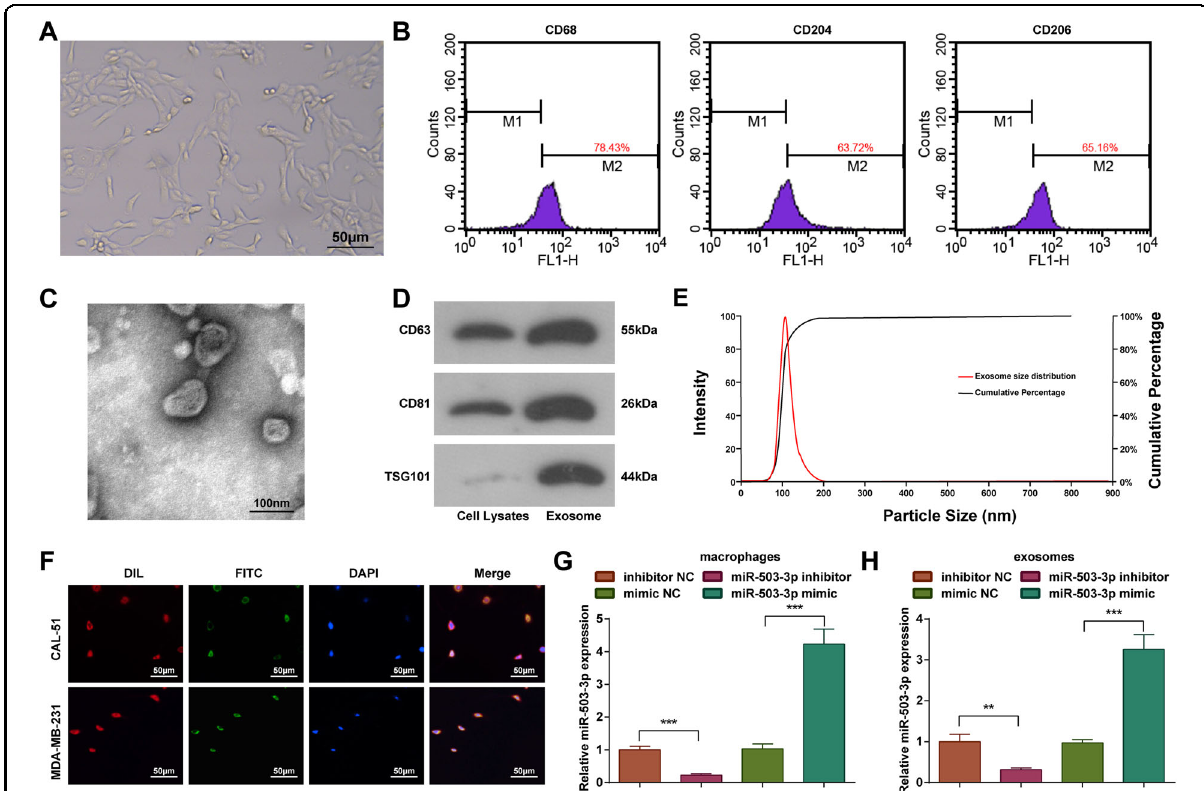
Fig. 4 Identi fi cation of macrophages and exosomes. A Morphology of PMA-induced macrophages; B identi fi cation of macrophages by fl ow cytometry; C identi fi cation of exosomes under a TEM; D western blot measured CD63, CD81, and TSG101 levels; E NTA measured size and concentration of exosomes; F FITC and DIL staining assessed the activity of exosomes entering cells; G , H RT-qPCR measured miR-503-3p expression in macrophages ( G ) and exosomes ( H ); repetitions = 3; ** P < 0.01; *** P < 0.001; the measurement data were expressed as mean ± standard deviation and compared using Student ’ s t